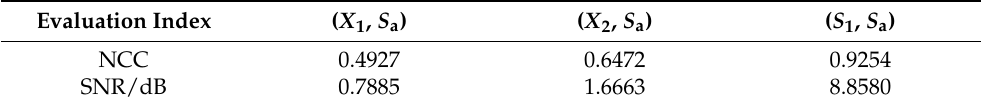
Table 3. Evaluation indexes of the proposed method separation